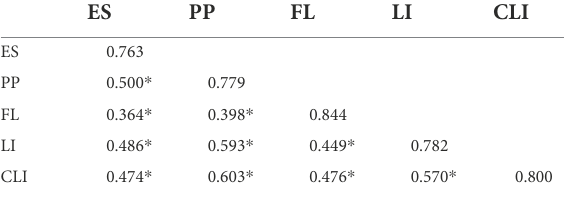
TABLE 6 Results of Fornell-Larcker criterion.